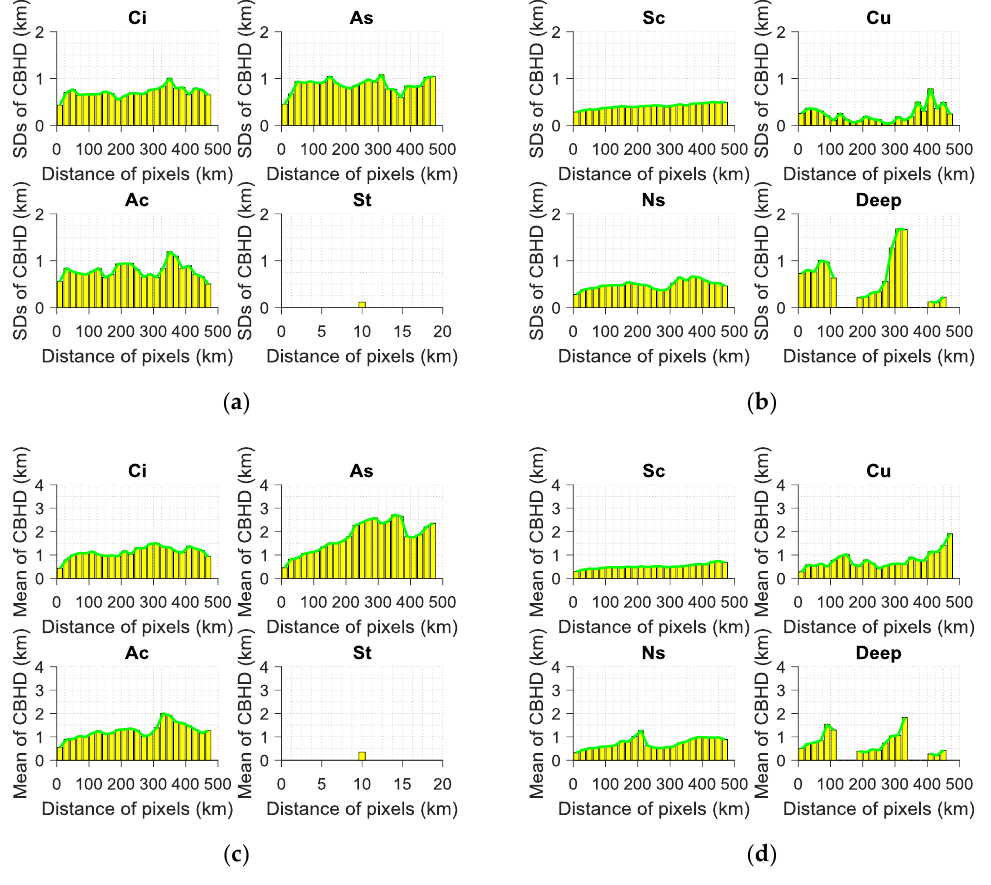
Figure 9. SDs ( a , b ) and mean values ( c , d ) of CBHD, along with the distance between recipient and donor pixels in May 2015, in the region 0~60° N and 70–140° E, where ( a , c ) are for cirrus (Ci), altostratus (As), altocumulus (Ac), and stratus (St), and ( b , d ) are for stratocumulus (Sc), cumulus (Cu), nimbostratus (Ns), and deep convective clouds (Deep).